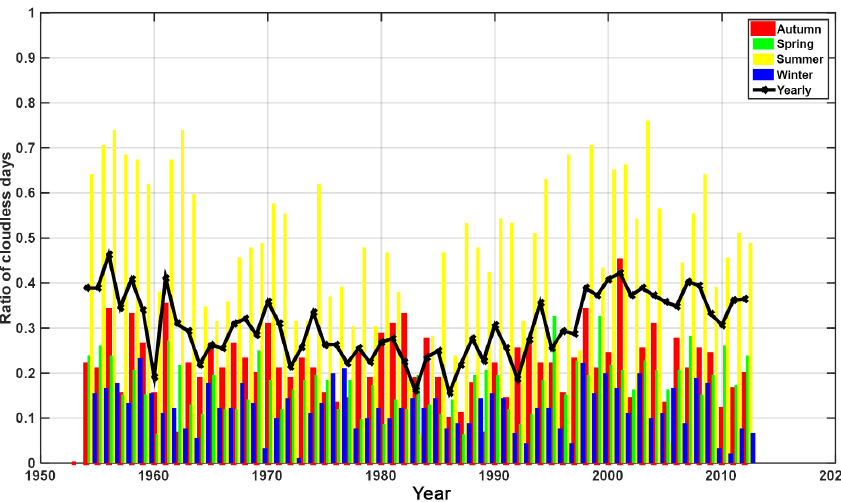
Figure 11. Ratio of cloudless vs. all days, per season and yearly. Table 4. Clear-sky and all-sky data trend comparison for the whole 1953–2012 period and the two 30-year sub-periods (%decade − 1 ). Percentages in parentheses show the limits of the 95% confidence bounds and in bold the yearly trends. Season Clear sky All skies Clear sky Clear